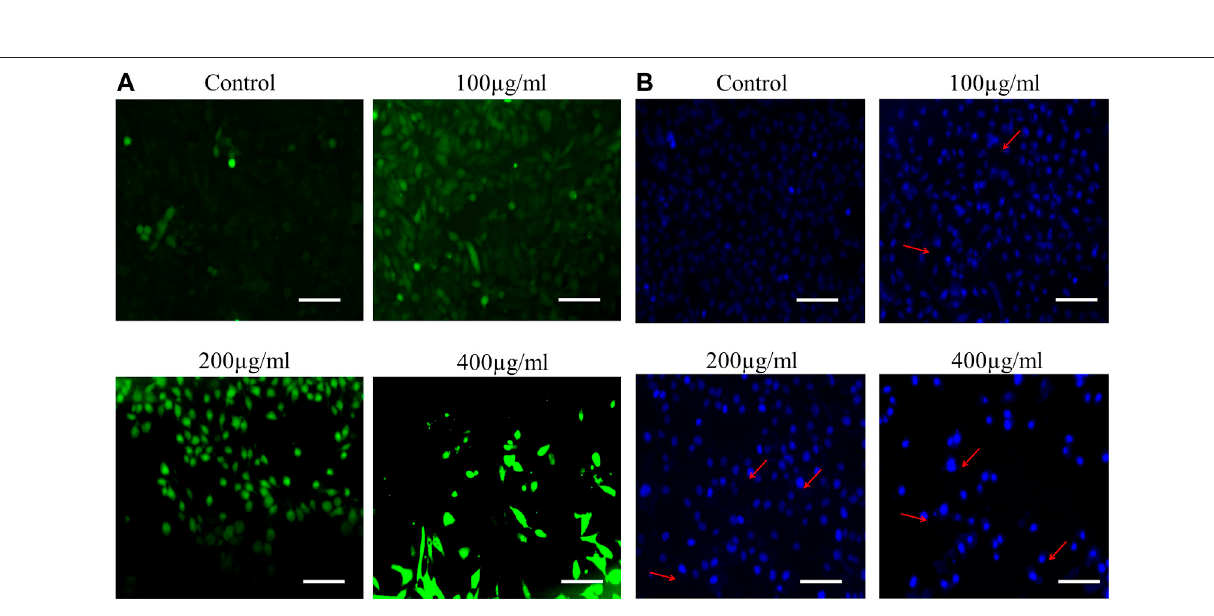
FIGURE 3 | (A) AOE-mediated induction of apoptosis within treated human lung cancer A549 cells. Increased levels of nuclear condensation and apoptosis are depictedwithinphotomicrographsofvehiclecontrolandAOE-treated (100 – 400µg/ml)A549cellsstainedwithHoechst33342byredarrows. (B) Enhanced intracellular ROS generation in DCHF-DA-stained A549 cells treated with AOE for 24 h. Scale bar = 100 μ m and magni fi cation =